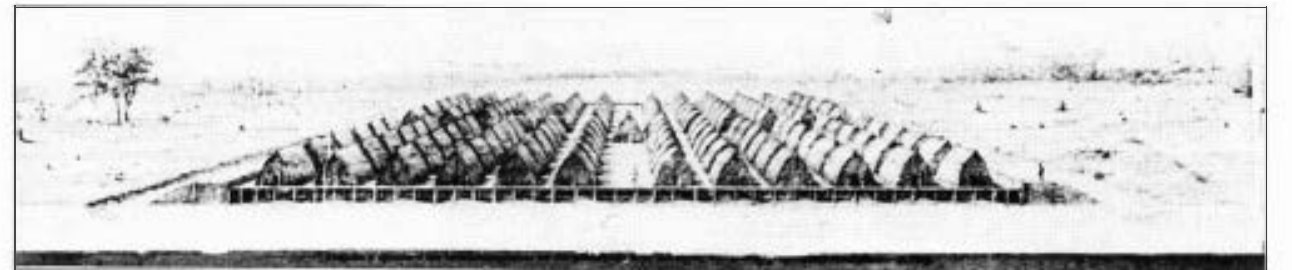
Figure 2 An idealized reconstruction by Chierici (seen. 2 below) of a Bronze Age terramara showing bank and ditch, (exaggerated) rectangular plan and (imaginary) street layout (from the reference cited in n . 5 below, p.